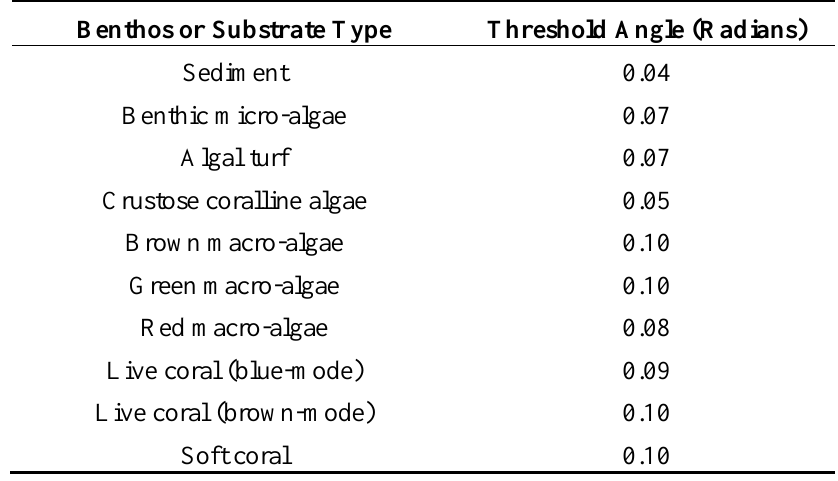
Table 2. Threshold angle (in radians) for each benthos and substrate type in the multi-radians SAM classification using image data bands 4–17. The same angle was used for the 20 depth modelled classes within each benthos and substrate